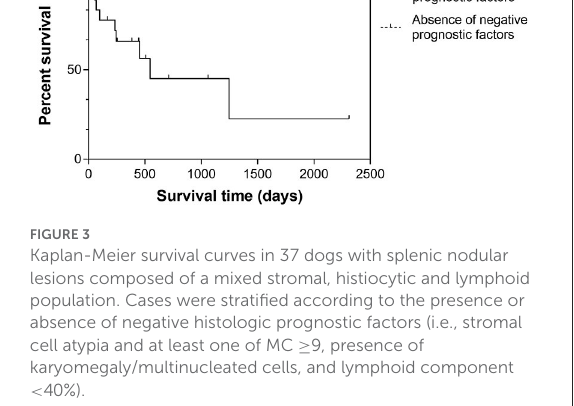
TABLE 2 Univariable Cox regression analysis of variables potentially associated with an increased risk of disease-related death in 37 dogs with mixed stromal, histiocytic and lymphoid splenic nodular lesions.